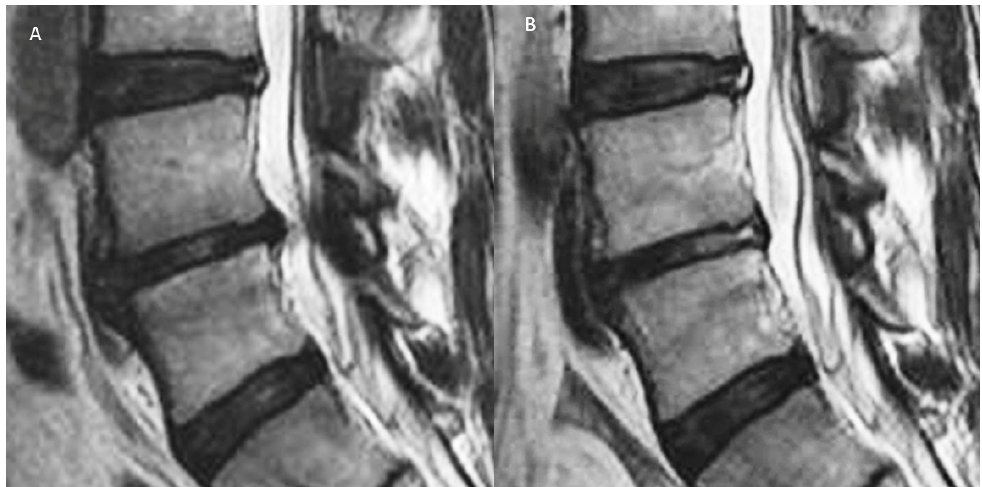
Figure 5. ( A ) Degenerative disc disease with Pfirrmann grade III disc, showing inhomogeneous structure, and an unclear distinction of nucleus and annulus and intermediate signal intensity in T2 image with slightly decreased disc height and disc bulge. ( B ) Radiofrequency ablation of the disc, sinuvertebral nerve and basivertebral nerve showing shrinkage of degenerative disc and there is an increase in the signal of Modic changes in the adjacent vertebra body.